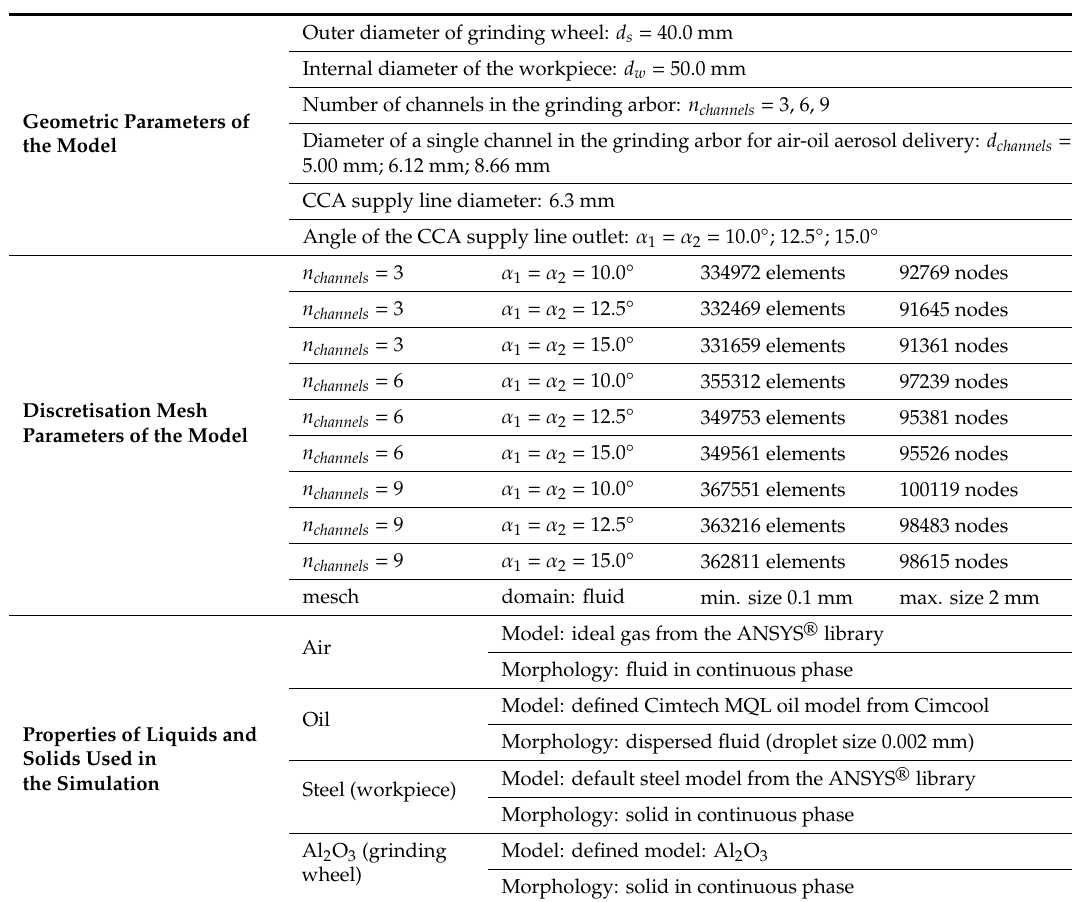
Table 4. Characteristics of simulation